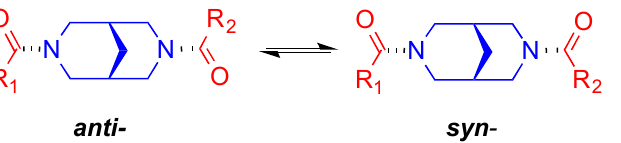
Scheme 2. Two stereoisomeric forms that appear in the case of N , N (cid:48)